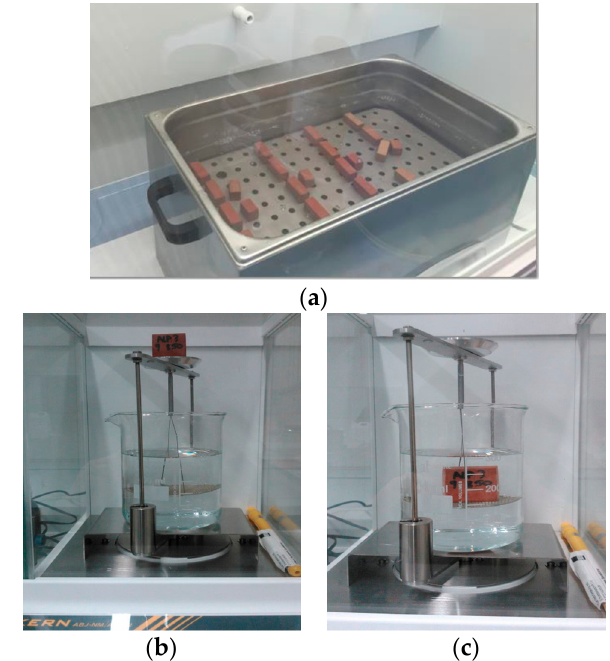
Figure 3. Apparent porosity and bulk density test. ( a ) Saturation in water; ( b ) Determination suspended mass; ( c ) Determination saturated mass.